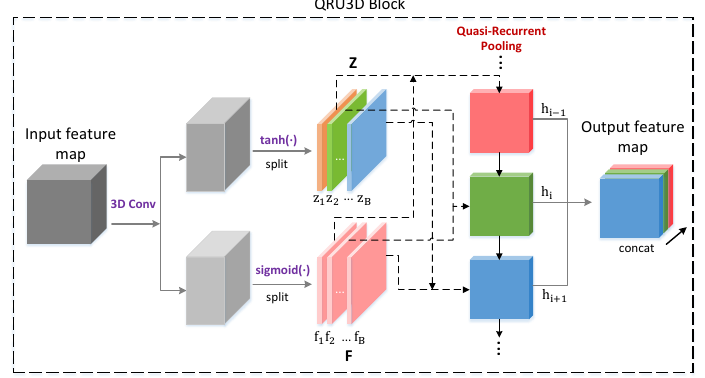
Figure 2. The structure of the 3D quasi-recurrent